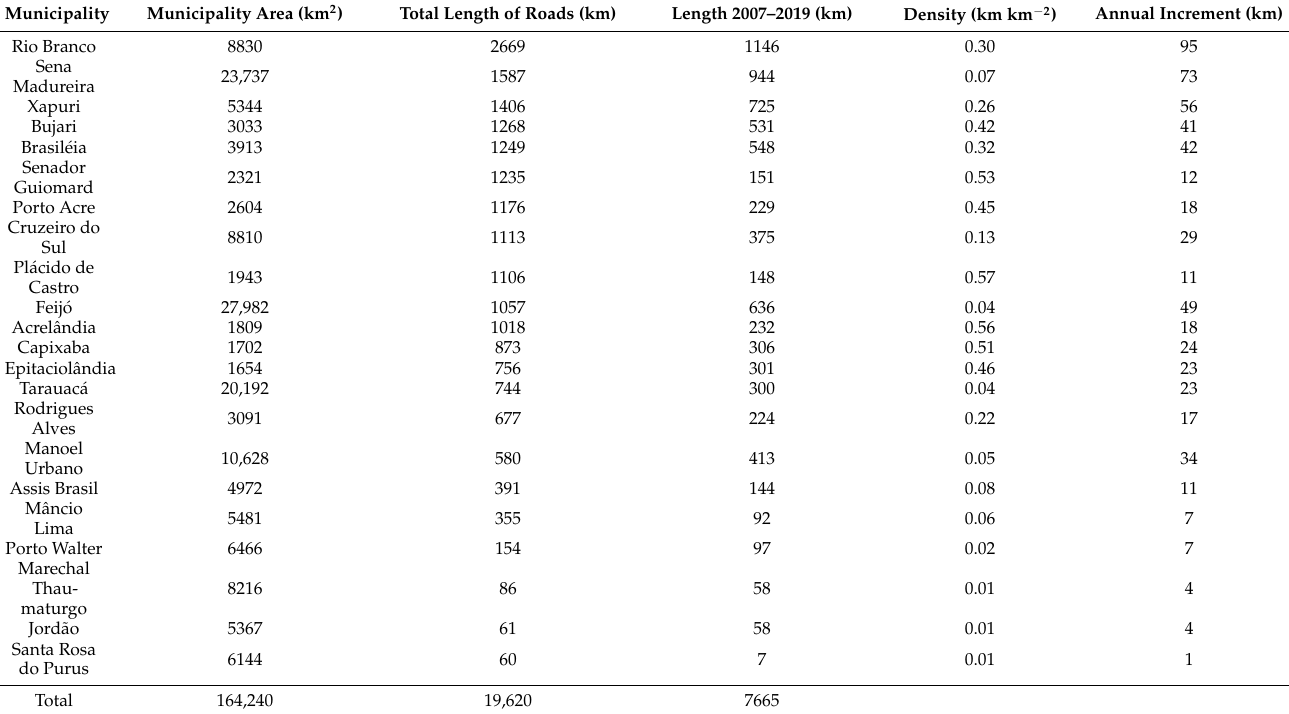
Table 1. The total length of roads, density, and annual increment by municipality of the State of Acre for the period 2007–2019. The list of municipalities is ranked by the highest total length of